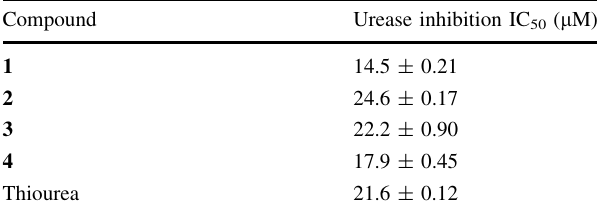
Table 2 Urease inhibition